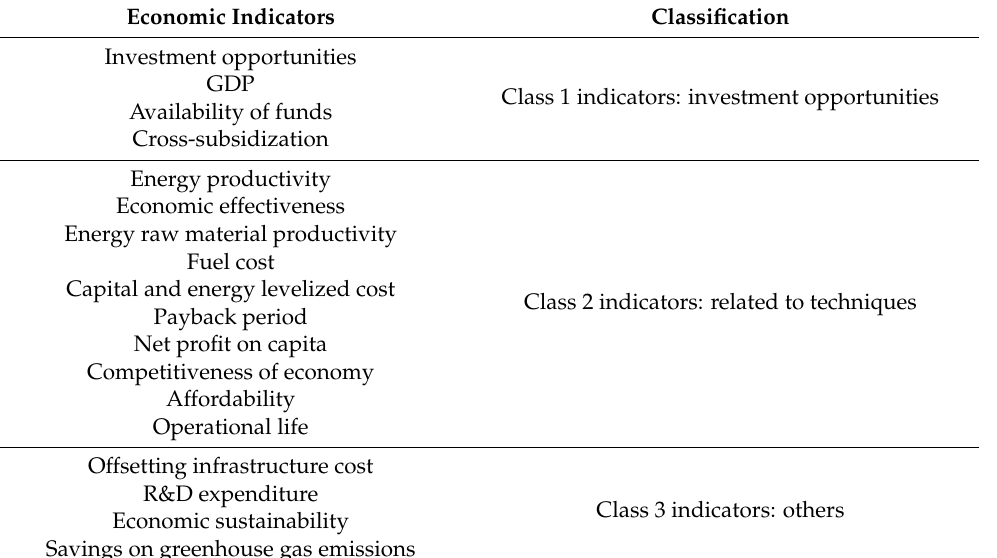
Table 2. The most commonly utilized economic indicators.